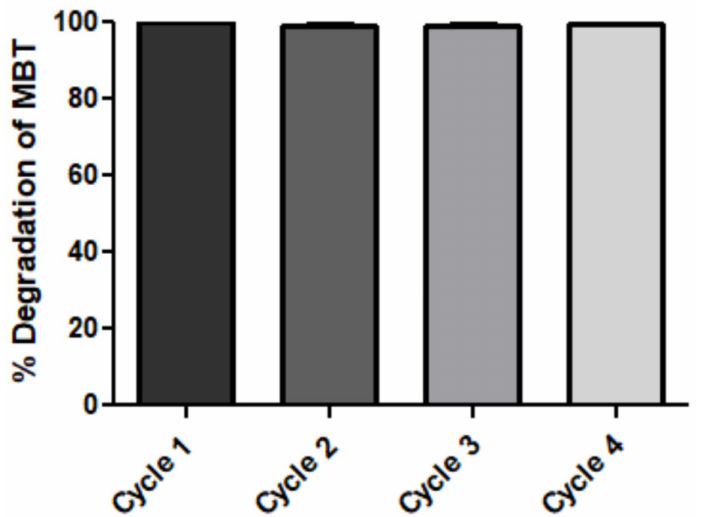
Figure 6. Recyclability of TiO 2 -SBP. After four consecutive degradation cycles of MBT by TiO 2 -SBP, the degradation efficiency of MBT was up to 95%. [MBT]= 2 ppm, 20 mg of TiO 2 -SBP, [H 2 O 2 ]= 0.6 mM (0.2 mM added 3 times of 10 min interval), [HOBT]= 0.1 mM, pH=4.